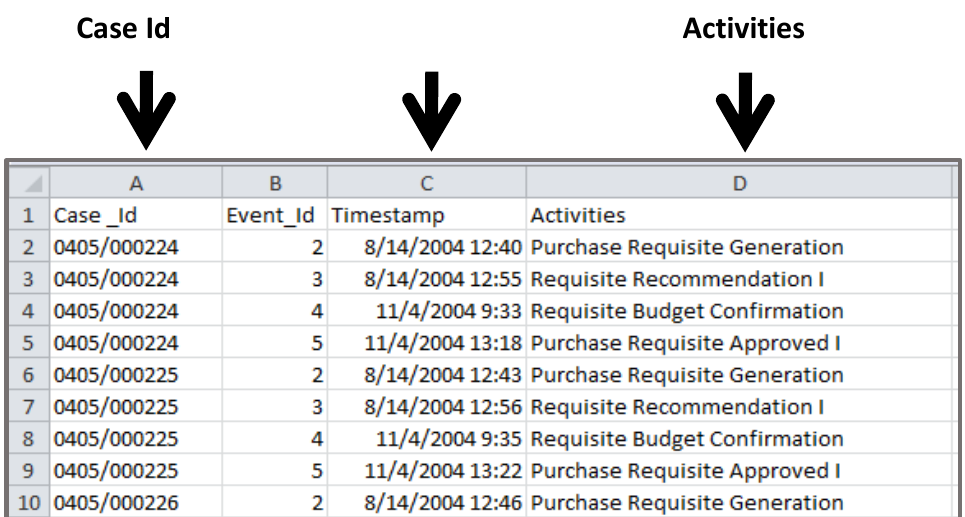
Figure 3. Data characteristics of provided event